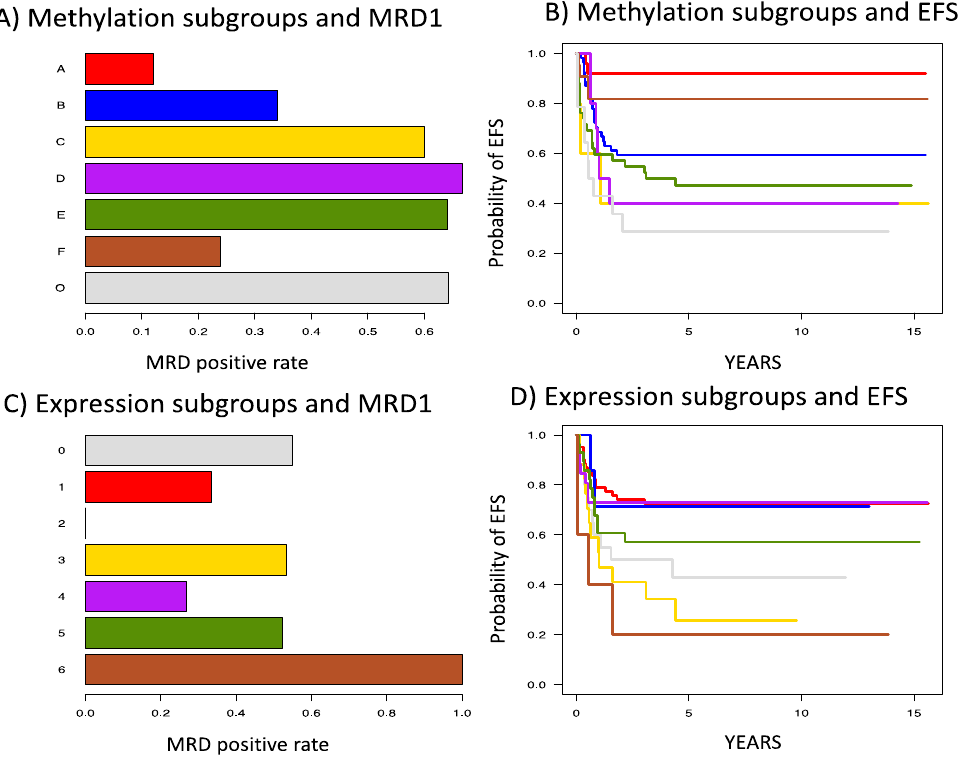
Figure 2. Association of the methylation clusters with ( A ) minimal residual disease after induction 1 (MRD1) and ( B ) Event free survival (EFS) and expression clusters with ( C ) MRD1 and ( D ) EFS in AML patients treated on AML02 clinical trial. The methylation and expression colors are as defined in Figure